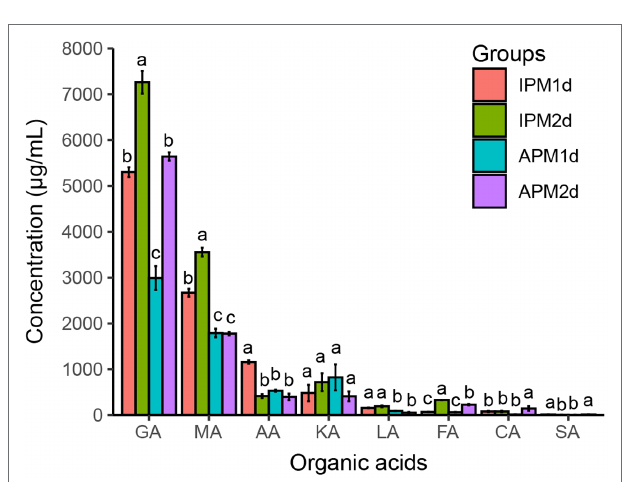
FIGURE 2 | The concentration of organic acids in IPM and APM groups. IPM1d and IPM2d represent 1 day and 2 days after inoculation of phosphate- solubilizing bacteria FP12 in the insoluble phosphorus medium, respectively. APM 1d and APM 2d represent 1 day and 2 days after inoculation of phosphate-solubilizing bacteria FP12 in the available phosphorus medium, respectively. GA, gluconic acid; MA, malic acid; AA, acetic acid; KA, α -ketoglutaric acid; LA, lactic acid; FA, formic acid; CA, citric acid; and SA, succinic acid. Different letters denote significant difference from a Tukey’s HSD test ( p <